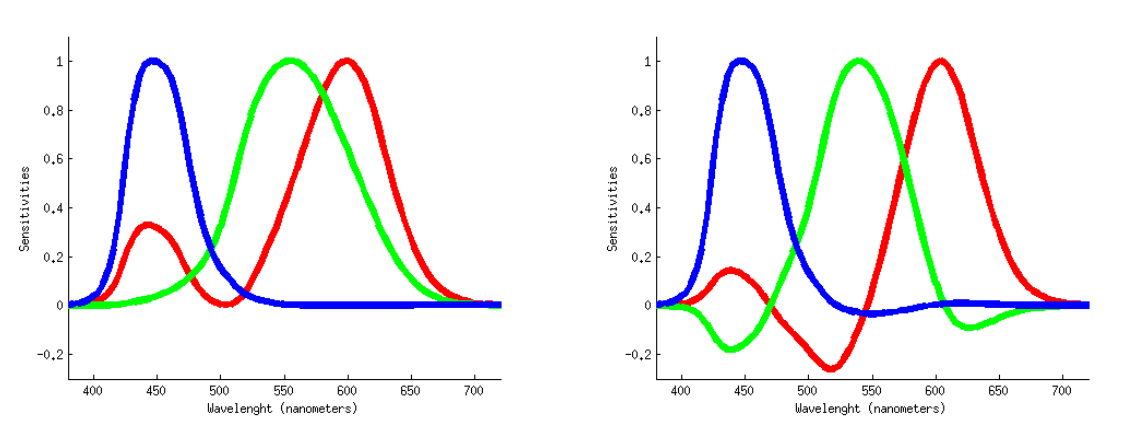
Figure 2. Original camera sensors ( left ) and their sharpened counterparts ( right